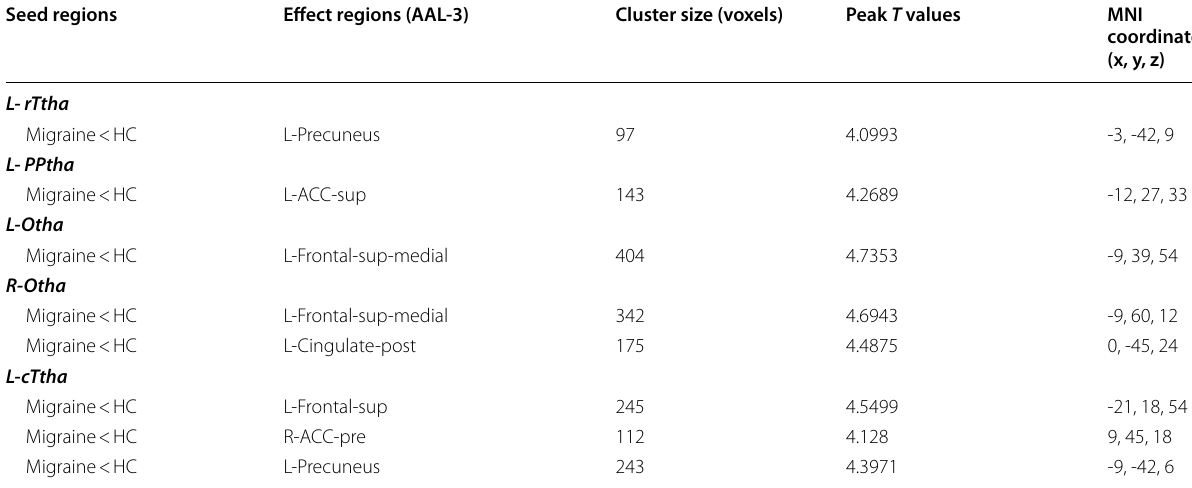
Table 2 Brain regions showing decreased rsFC between the thalamic subregions and cerebral cortex in patients with episodic migraine compared with